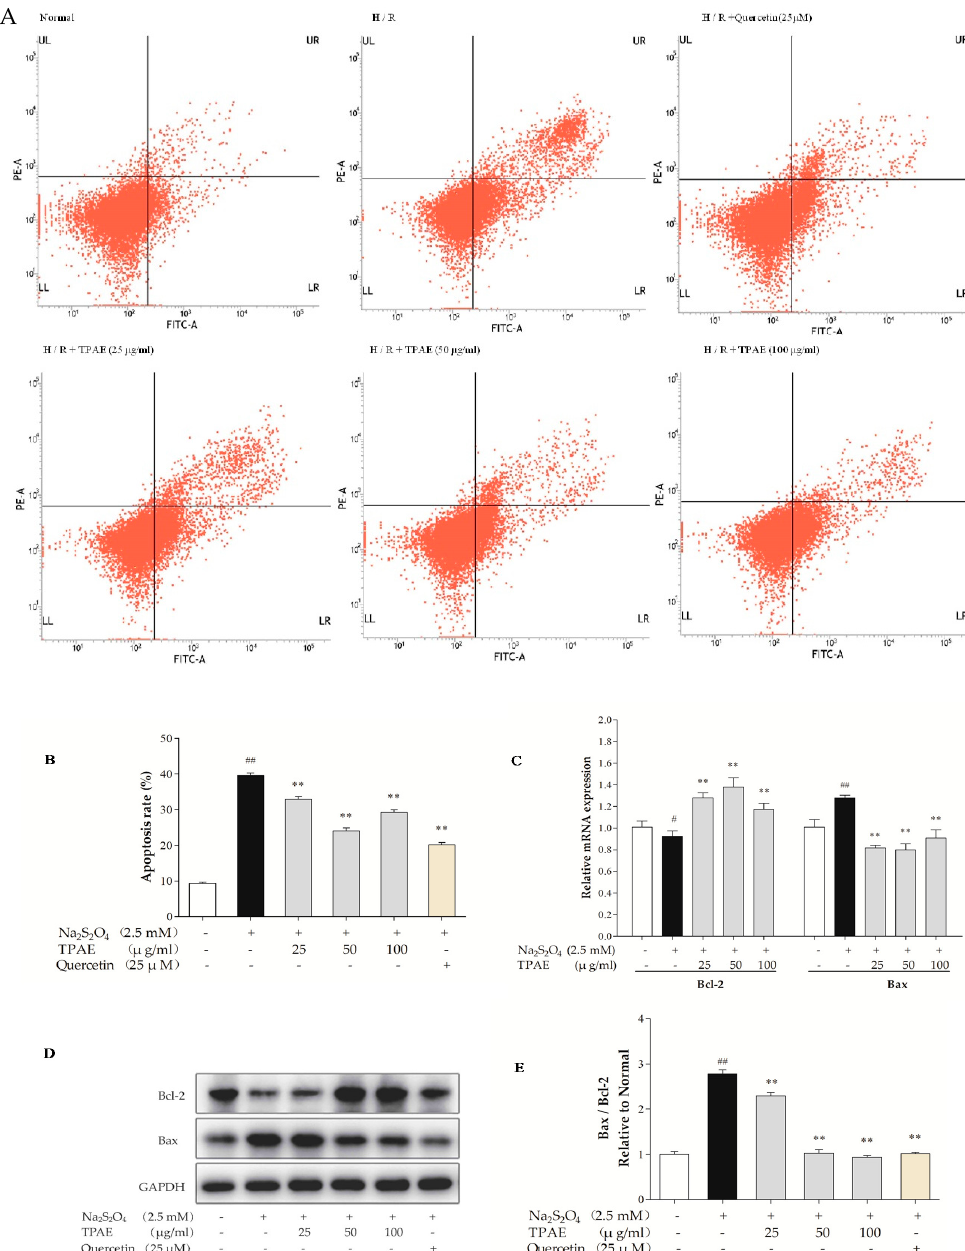
Figure 2. Effects of TPAE on H/R induced H9c2 cardiomyocytes apoptosis. H9c2 cells were pretreated with three dosages of TPAE for 24 h followed by H/R. ( A ) The apoptotic ratio of H9c2 cells was measured by flow cytometry using Annexin V-FITC and PI staining; ( B ) The apoptosis rate was quantified by BD FACSVerse software; ( C ) The relative mRNA expression of Bcl-2 and Bax was determined by qRT-PCR; ( D ) Immunoblots of Bcl-2, Bax and glyceraldehydes-3-phosphate dehydrogenase (GAPDH) was detected by western blotting; ( E ) Quantitative analysis of the ratio of Bax to Bcl-2 in protein expression was evaluated. Values were represented as mean ± SD (n = 3, each group). The results were representative of three independent experiments. # p < 0.05, ## p < 0.05 vs. normal group; * p < 0.05, ** p < 0.01 vs. H/R group.